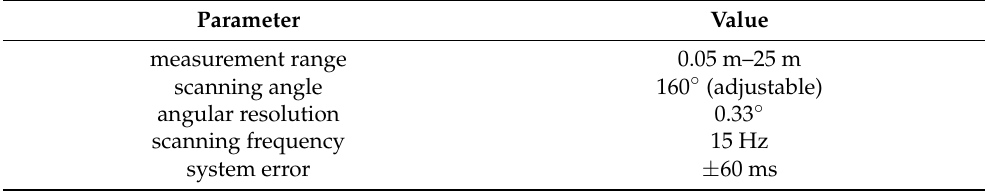
Table 2. SICK TIM571 Parameters.